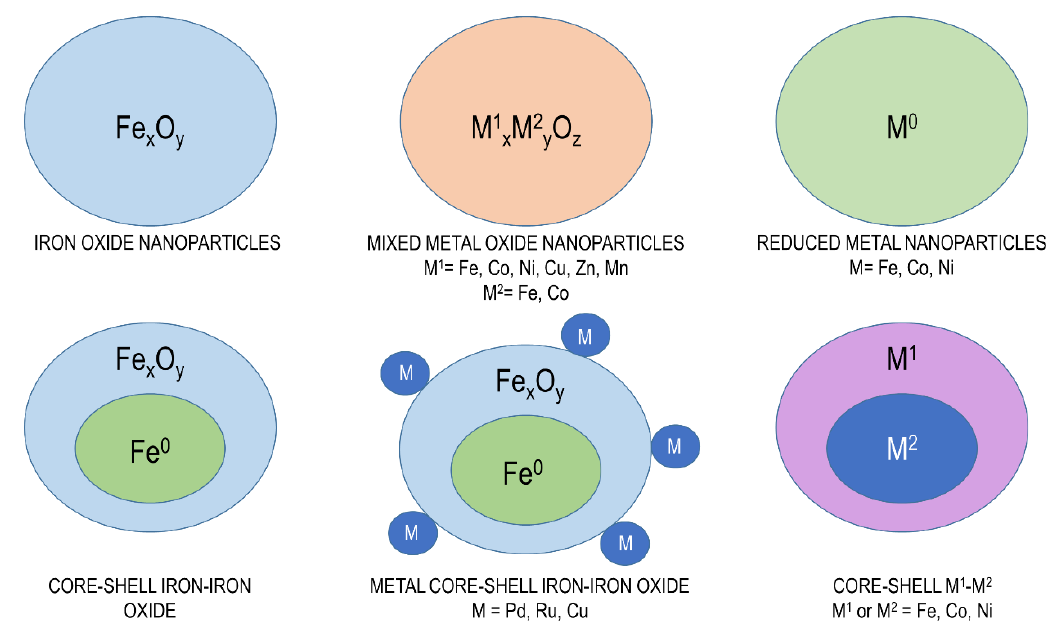
Figure 3. Types of catalysts based on magnetic nanoparticles.